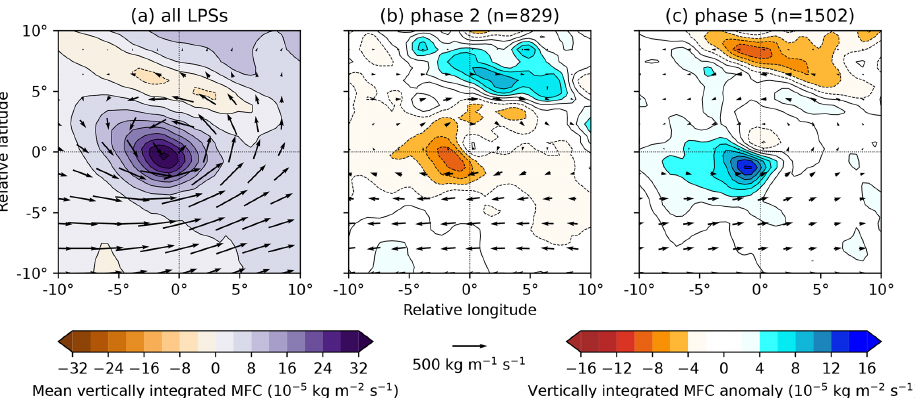
Figure 8. The effect of the BSISO on vertically integrated moisture flux and moisture flux convergence (MFC) in monsoon LPSs north of 15 ◦ N. The composite for all such LPSs is given in (a) , with the differences for LPS composites from BSISO phases 2 and 5 given in (b) and (c) respectively, along with their sample